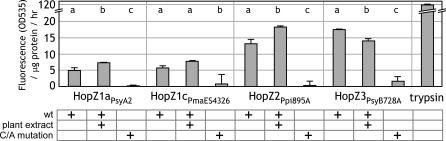
Protease Activity of HopZ T3SEs in P. syringae
Protease activity of HopZ1aPsyA2, HopZ1cPmaES4326, HopZ2Ppi895A, and HopZ3PsyB728a measured using Invitrogen RediPlate 96 EnzChek Protease Assay Kit green fluorescence is shown as fluorescence production (OD 535) after a 1-h incubation of the purified His-tag fusion proteins with a green fluorescence–labeled substrate at room temperature. Trypsin was used as a positive control. The grid along the bottom of the figure indicates if the wild-type protein was used, if plant extract was added to the reaction, or if the cysteine-to-alanine mutant protein was used. The error bars indicate standard errors between two replicates. Each experiment was repeated three times with similar results except for HopZ3PsyB728a, which gave inconsistent results due to instability of the protein. A gelatine in-gel protease assay was performed to confirm the enzymatic activity of HopZ3PsyB728a. Letters above the histogram bars indicate significance classes from a Fisher's Least Significant Difference test.wt, wild-type.